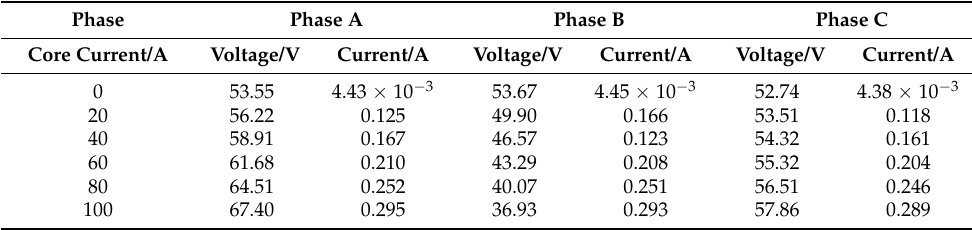
Table 7. Simulation value of induced voltage and calculating current of metal sheath with a common sheath protector when there is a single